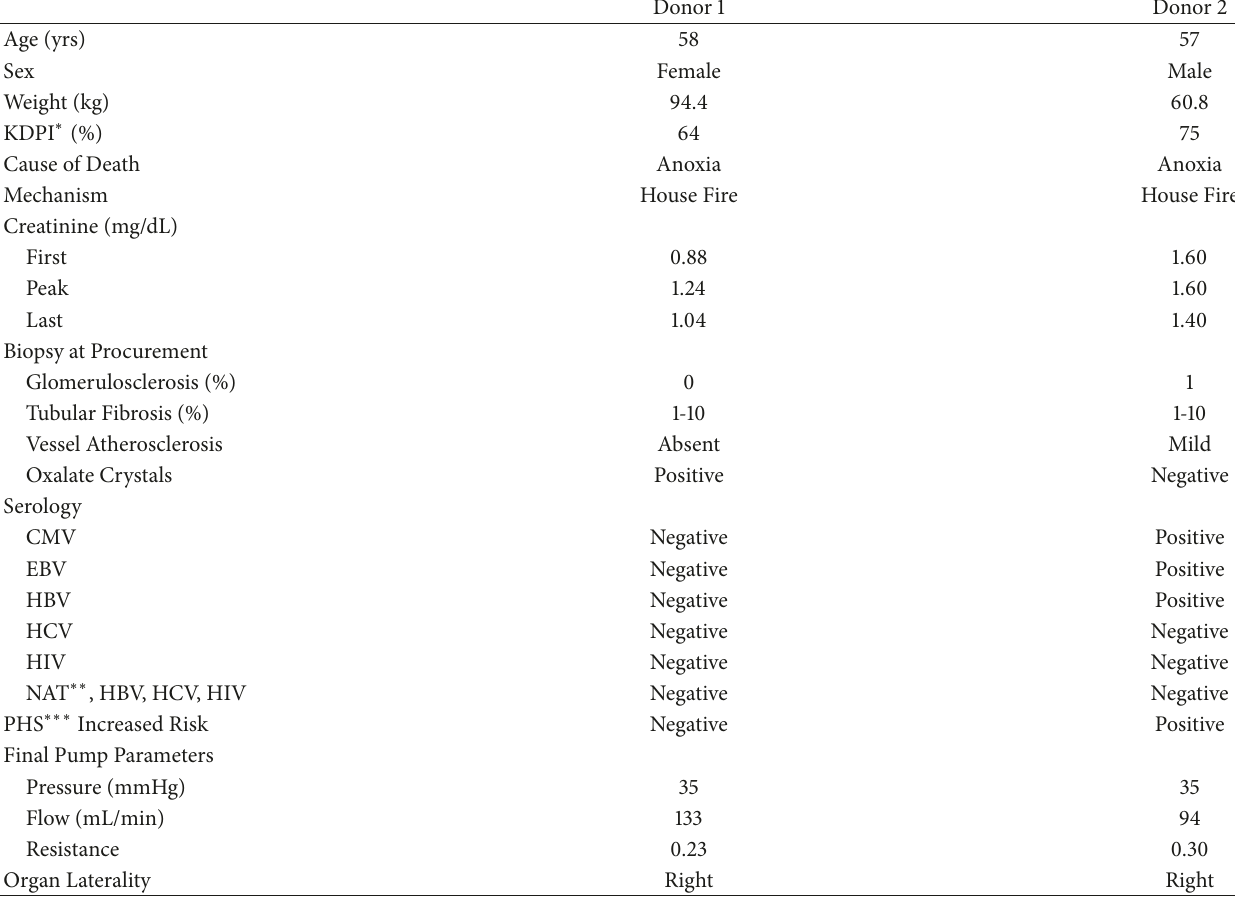
Table 1: Donor demographics and organ parameters.